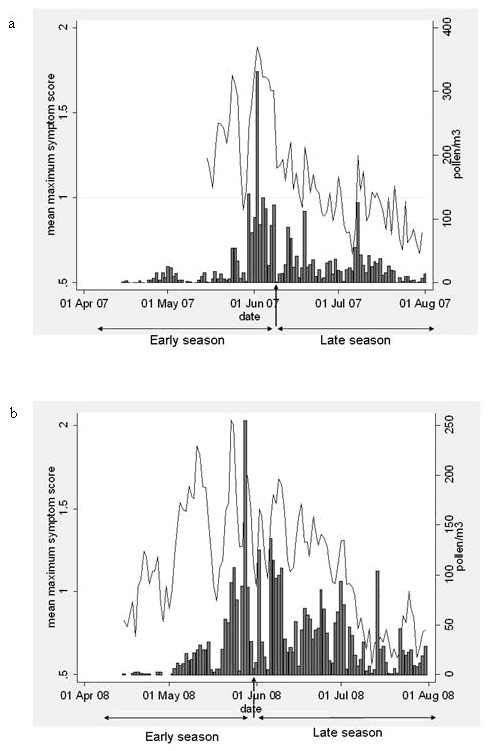
Daily mean of the maximum symptom score (line) in 2007 (a) and 2008 (b). The bars show the daily grass pollen counts. The season is split into an early and late season on June 12th in 2007 and May 31st in 2008 (indicated by arrows).